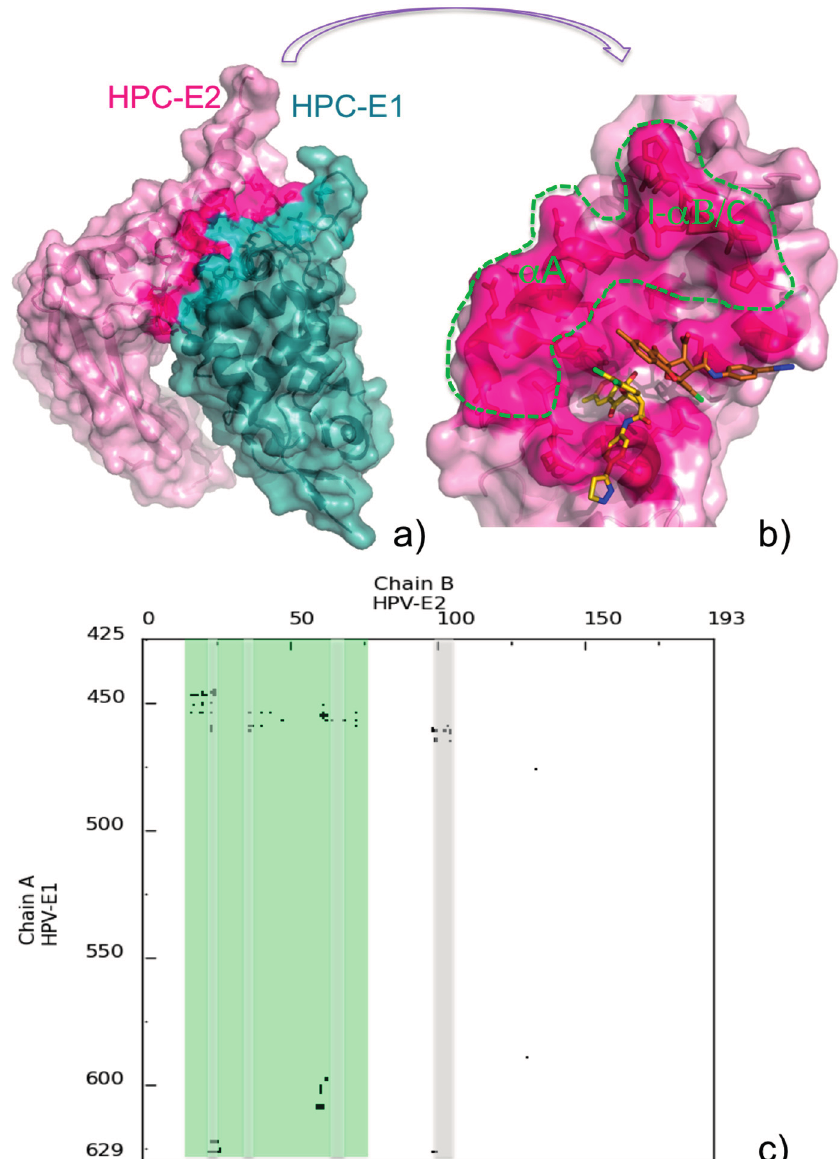
Figure 6. ( a ) COCOMAPS 3D representation of the HPC E1-E2 complex (PDB ID: 1TUE), with interface residues highlighted in teal and hot pink, respectively; ( b ) Inhibitor molecules binding to E2 in the 1R6N complex are shown on the E2 interface colored and displayed as in ( a ). The inhibitor molecules A and B (see text) are colored gold and copper, respectively. The E2 interface untargeted by inhibitors is rimmed with a green dashed line. Labels have been added for the E2 helix A ( α A) and the loop between helix B and C (l- α B/C); ( c ) Contact map of the HPC E1-E2 complex. E2 regions contacted by the inhibitors are shadowed in gray, and other regions available for possible inhibitor binding are shadowed in